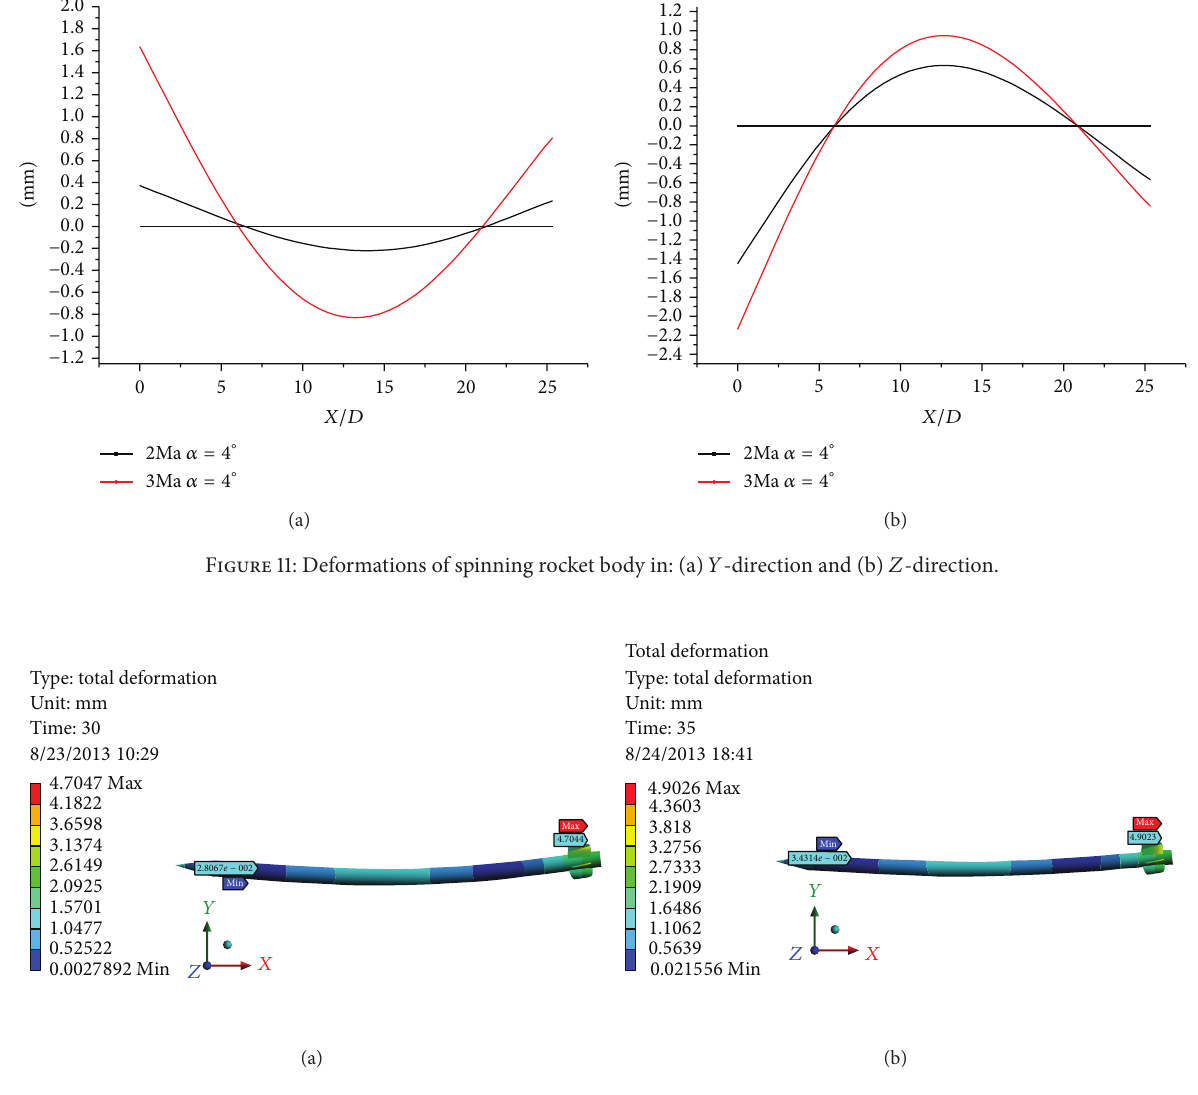
Figure 12: Total deformation distribution at Ma = 3 and 𝛼 = 4 ∘ of the rocket: (a) nonspinning and (b)